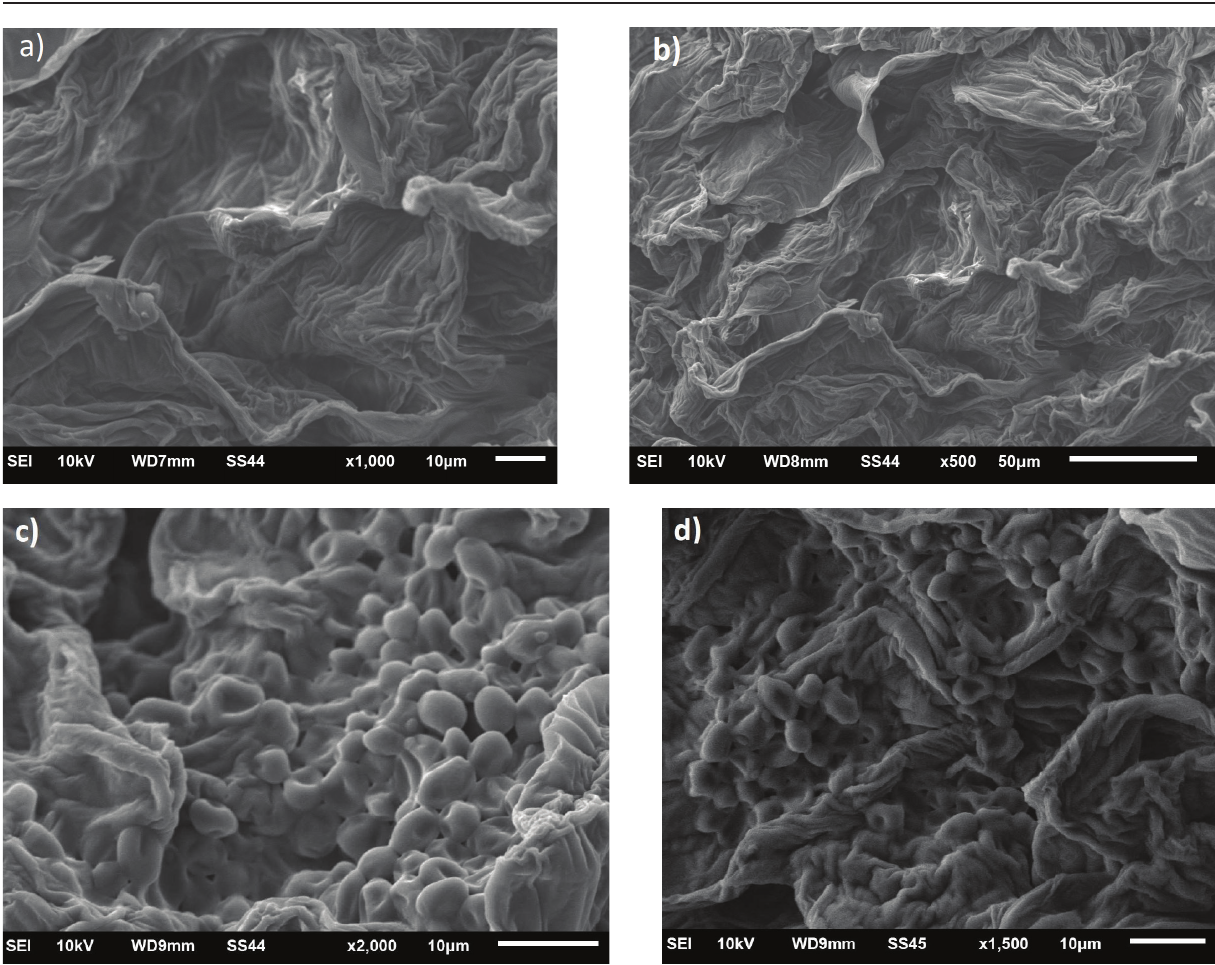
Fig. 5 – Scanning electron microscopy of supports without use (a,b) and after three successive usages in batch experiments of beer fermentation